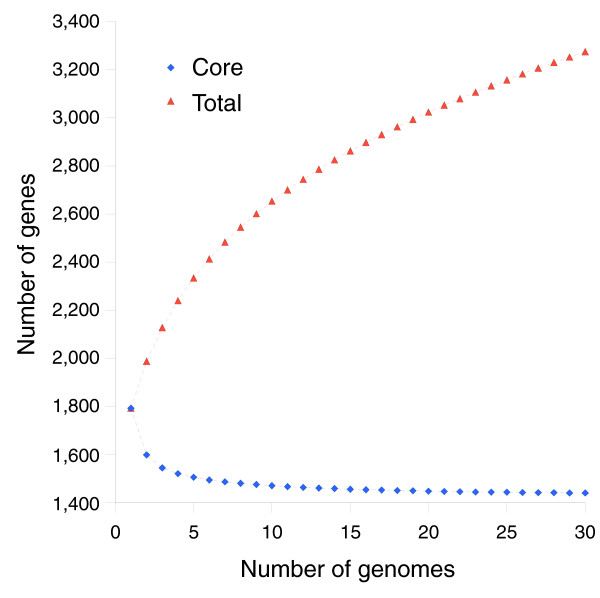
A theoretical plot of the number of total genes and core genes expected among N sequenced H. influenzae genomes for future sequencing projects. The extrapolation may not hold for strains isolated outside of North America since the plot was constructed using only North American isolates. The number of core genes approaches an asymptote, which reflects a common set of genes present in all natural isolates.